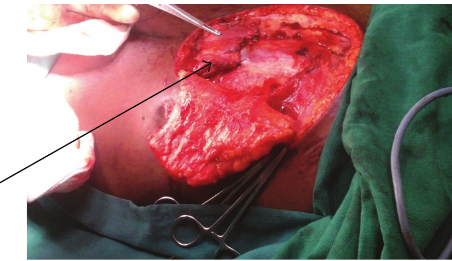
Figure 4: Latissimus dorsi muscle inserted into the